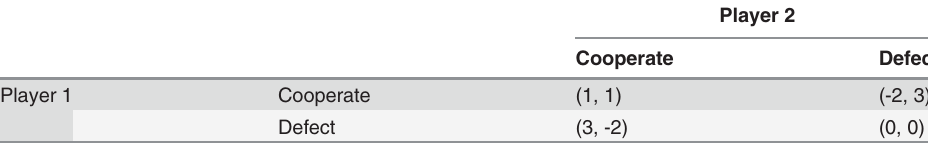
Table 1. Payoffs accruing to (Player 1, Player 2) in step